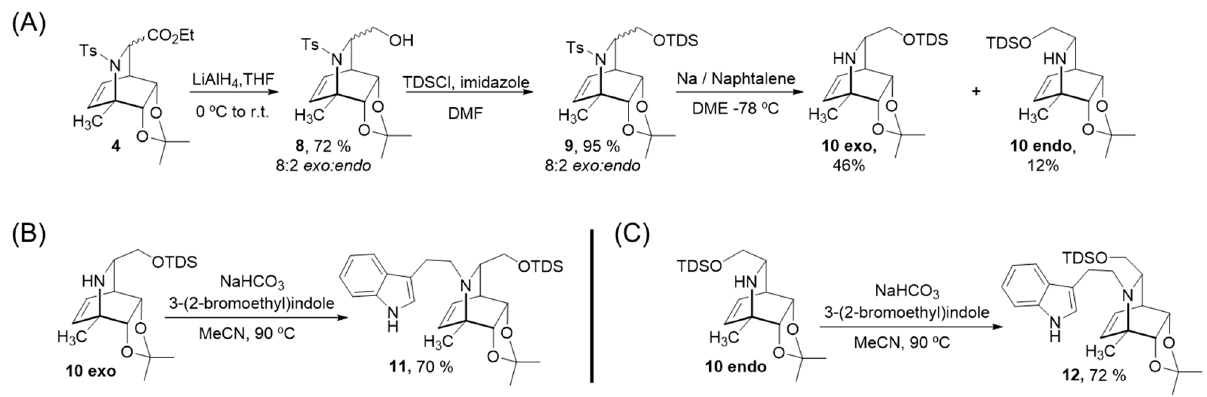
Figure 3. ( A ) Preparation of free amines 10 exo and 10 endo from esters mixture 4. ( B ) Preparation of derivative 11 . ( C ) Preparation of derivative 12 .